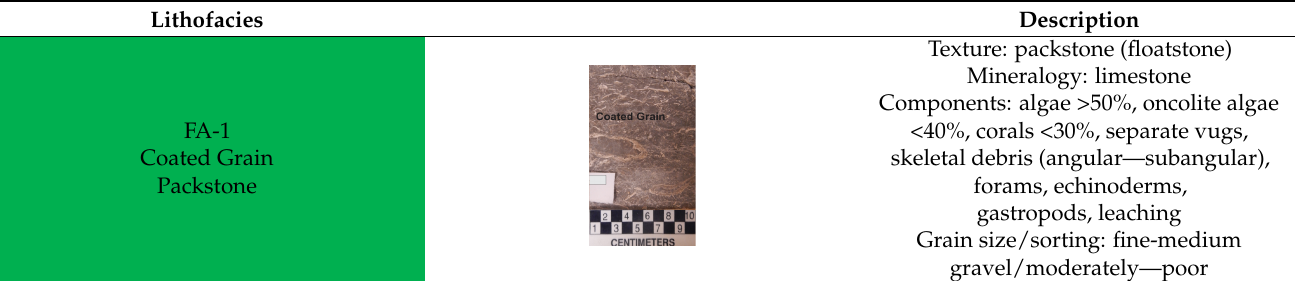
Table 5. Lithofacies for Central Luconia carbonates based on depositional texture and wireline-log response (adopted from Janjuhah et al. [9]).